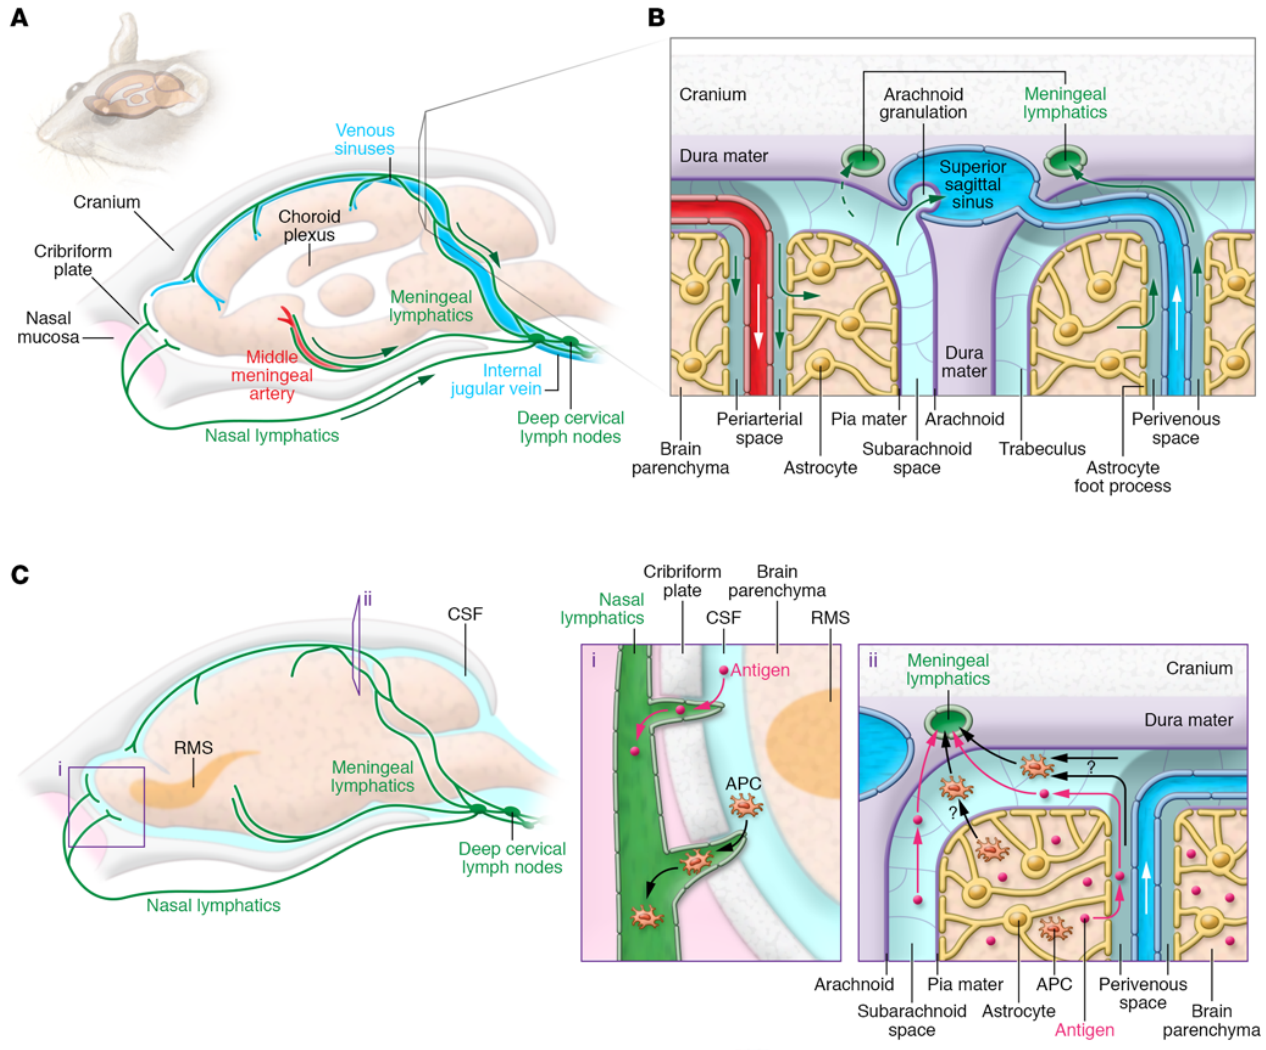
Figure 1. The cervical lymph nodes through the CNS’s lymphatic and lymphatic drainage pathways. ( A ) The meningeal lymphatic vascular system is depicted schematically in the mouse brain. Along with the venous sinuses, arteries, and cranial nerves, the dural lymphatic vessels leave the cranium through the foramina in alignment with the dural blood vessels and cranial nerves. Along with the olfactory nerves, certain lymphatic veins may be seen crisscrossing the cribriform plate. Tracers injected into the SAS or brain parenchyma drain into the dcLNs adjacent to the jugular vein through the dural lymphatic arteries. ( B ) ISF and CSF circulation up close. CSF and solutes are transported into the brain via the perivascular glymphatic drainage system through the periarterial pathway, whereas ISF and solutes are transported out of the brain by the perivenous glymphatic pathway. CSF macromolecules and immune cells are mostly carried by the dural lymphatic channels into the lymph nodes and extracranial systemic circulation, and CSF can reach the venous system via arachnoid granulations. ( C ) Routes for antigens and antigen-presenting cells to exit the central nervous system (APCs). Dendritic cells, in particular, may migrate along the rostral migratory stream (RMS) to enter the lymphatics via the olfactory bulb’s SAS. Alternatively, antigens and APCs are proposed to leave the CNS via the glymphatic pathway (as demonstrated for antigens), reaching the SAS and entering the meningeal lymphatic vasculature via SAS and trafficking to the dcLNs. APCs in the meningeal spaces may also go to the dcLNs through meningeal lymphatic channels. It is still unknown how much each mechanism contributes to cell and antigen outflow. Reproduced with permission from